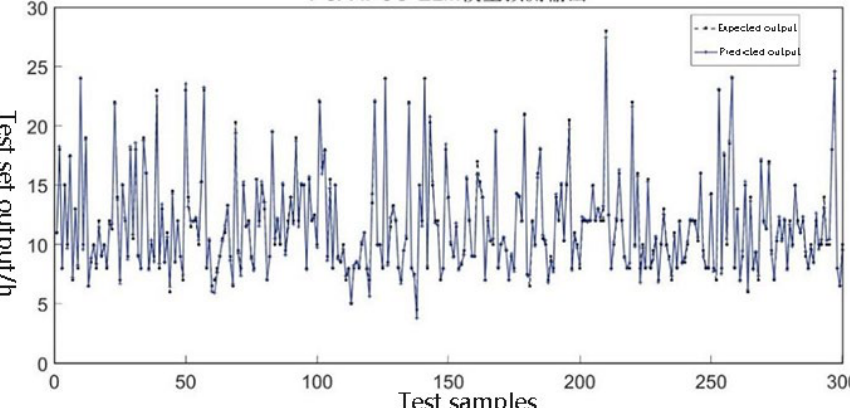
Figure 6. Comparison of predicted value and expected value of PCA-IPSO-ELM model. In Figure 6, the black dotted line indicates the expected output value, and the blue solid line indicates the predicted output of the model. The predicted trend is consistent with the actual container ship’s berth operation, and the fitting degree of the model is good. At the same time, it can be seen from Figure 7 that the absolute prediction error of the PCA-IPSO-ELM model is generally in a low floating range. It can be inferred that this model has good prediction performance in predicting the berth operation time of container